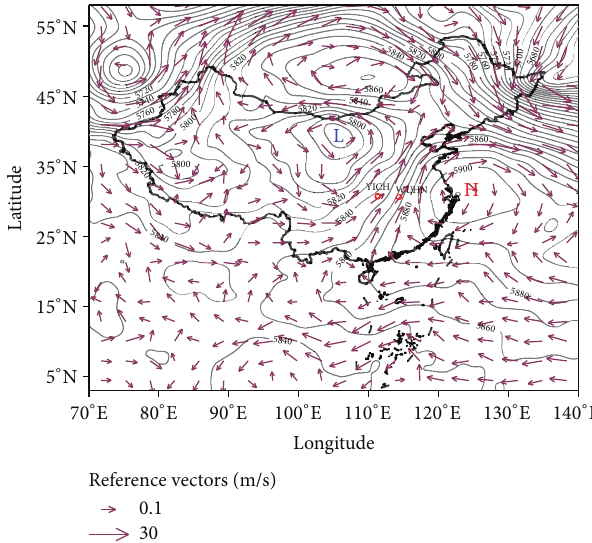
Figure 4: Geopotential height and wind field for 500 hPa in East Asia at 20:00 p.m. on July 27, 2007. The hollow red circles show the locations of the YICH and WUHN stations. The data in the figure were derived from the National Centers for Environmental Prediction (NCEP) 1 ∘ × 1 ∘ reanalysis